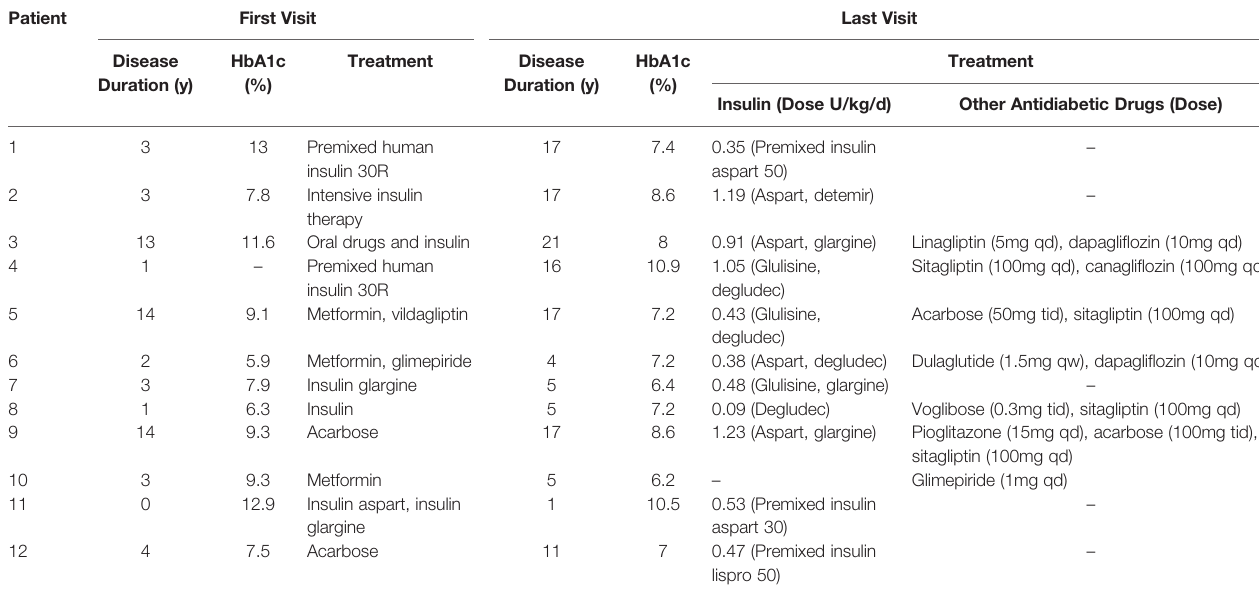
TABLE 3 | HbA1c values and treatment regimens before and after follow-up. Patient First Visit Disease Duration